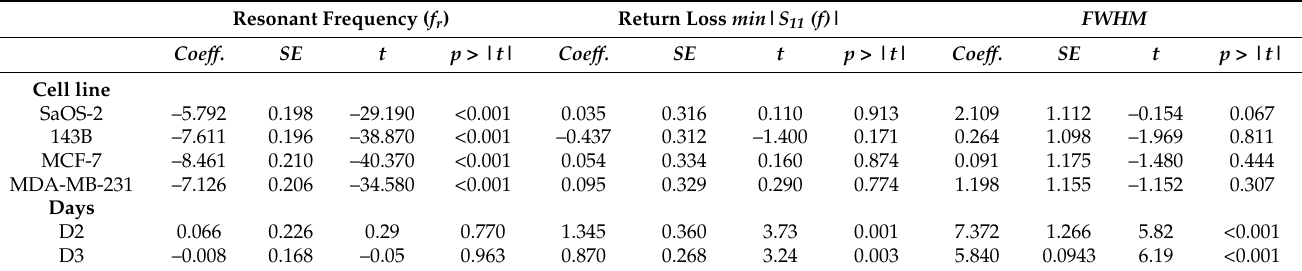
Table 3. ANOVA results for each dependent variable with respect to cell line and day factors.